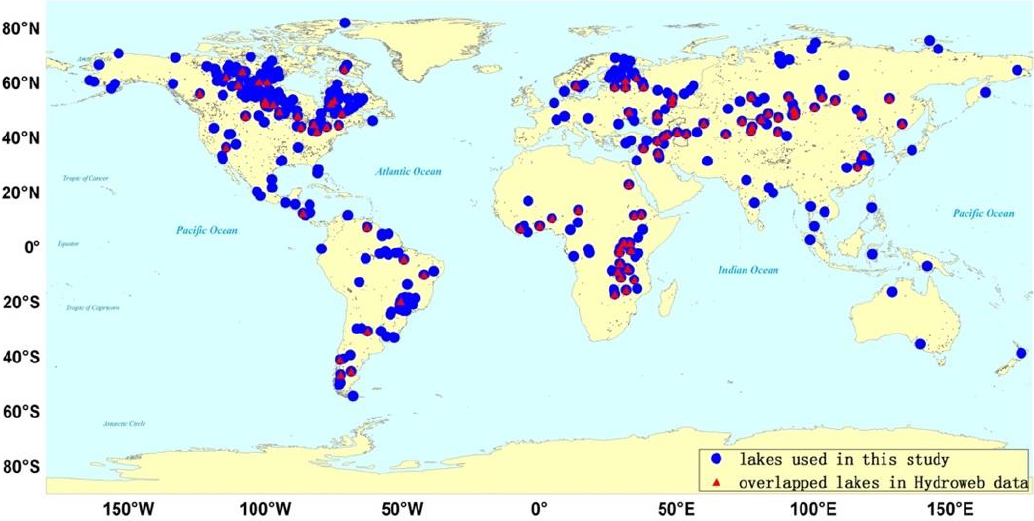
Figure 1. Global lakes (area greater than 500 km 2 and elevation lower than 3000 m each) used for water level retrieval in this study. There are 351 lakes (blue solid circles), with 284 in the Northern hemisphere and 67 in the Southern hemisphere. Red solid triangles represent the overlapped 89 lakes in the Hydroweb data. All the lakes are overlapped with the Cryosat-2 data.